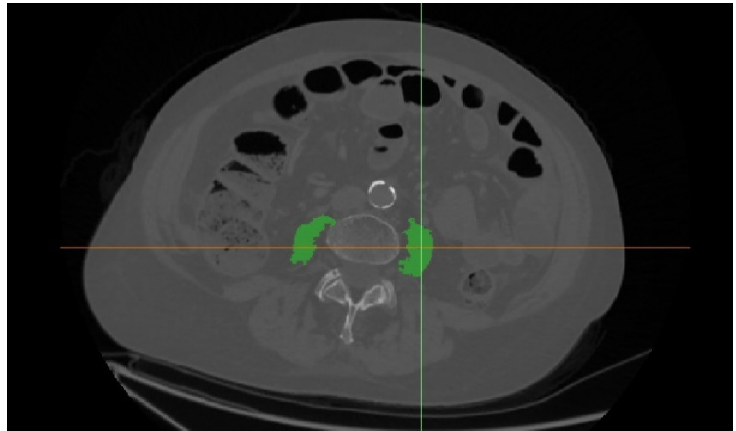
Figure 2. Bilateral psoas muscles area.